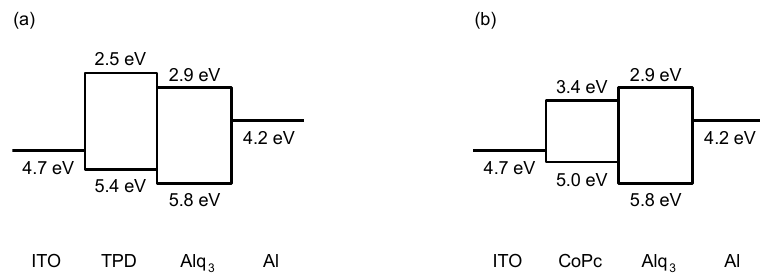
Figure 1. Energy diagram of the ITO/TPD/Alq 3 /Al device ( a ) and ITO/CoPc/Alq 3 /Al device ( b ). The energy levels of organic materials and electrodesare cited from [12].